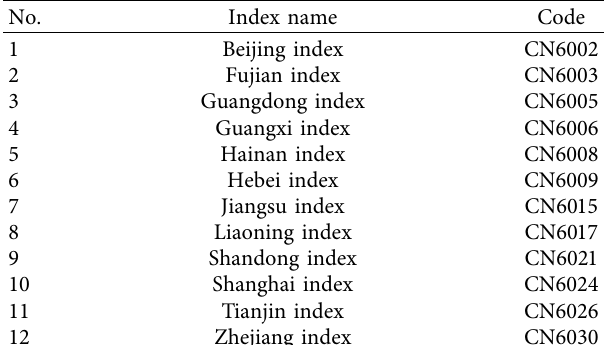
Table 1: The details of the 12 regional